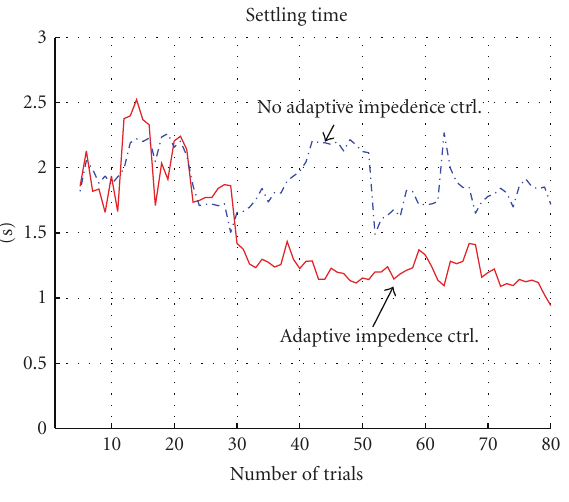
Figure 11: Evolution of settling time.